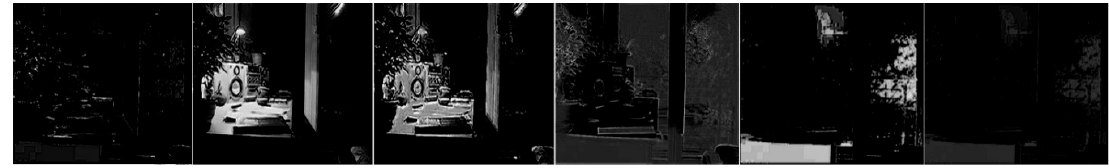
Figure 7. The f eature maps learned in the nonlinear mapping part. Figure 7. The feature maps learned in the nonlinear mapping